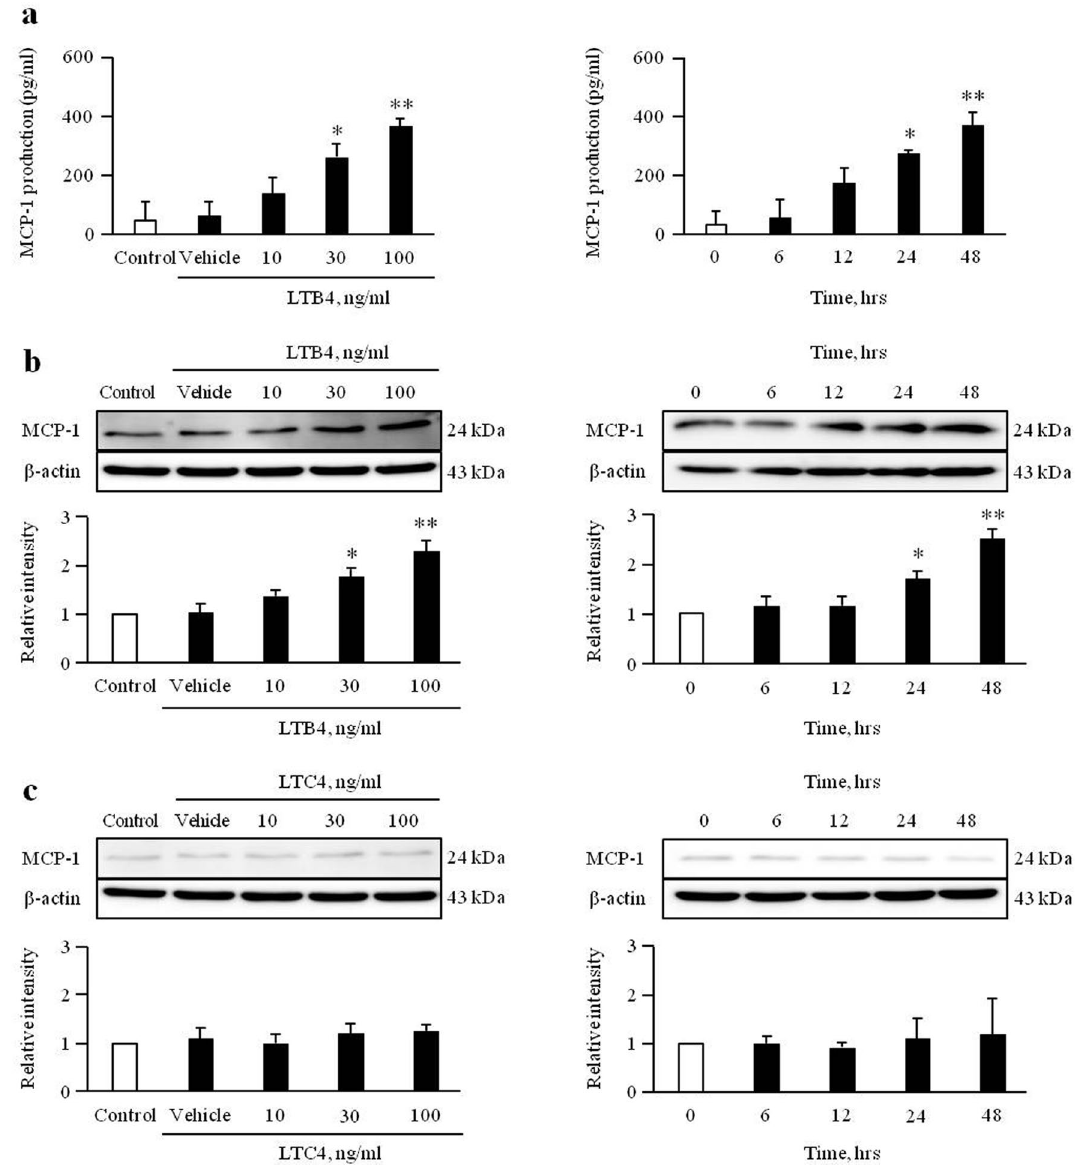
Figure 4. Role of LTB4 and LTC4 on MCP-1 production and expression in VSMCs. VSMCs were treated with LTB4 (0 to 100 ng/ml) for 48 h, or LTB4 (100 ng/ml) for 0 to 48 h. ( a ) MCP-1 production was measured in the cell culture media, and results were expressed as the mean ± SEM of 3 independent experiments. * p < 0.05 and ** p < 0.01 vs. corresponding value at control or 0 h. ( b ) The expression levels of MCP-1 were determined by Western blotting using β-actin as an internal control. Results were expressed as the mean ± SEM of 4–5 independent experiments. * p < 0.05 and ** p < 0.01 vs. corresponding value at control or 0 h. ( c ) VSMCs were treated with LTC4 (0 to 100 ng/ml) for 48 h, or LTC4 (100 ng/ml) for 0 to 48 h. The expression levels of MCP-1 were determined by Western blotting using β-actin as an internal control. Results were expressed as the mean ± SEM of 3 independent experiments. Image analysis was performed using the Amersham-Imager 680, ver. 2.0. software (https:// www. cytiv alife scien ces. com/). Signal was quantified with GraphPad Prism 5, ver. 5.01. software (https:// www. graph pad. com/). Cropped gels were displayed and full-length blots/gels are presented in supplementary Fig.